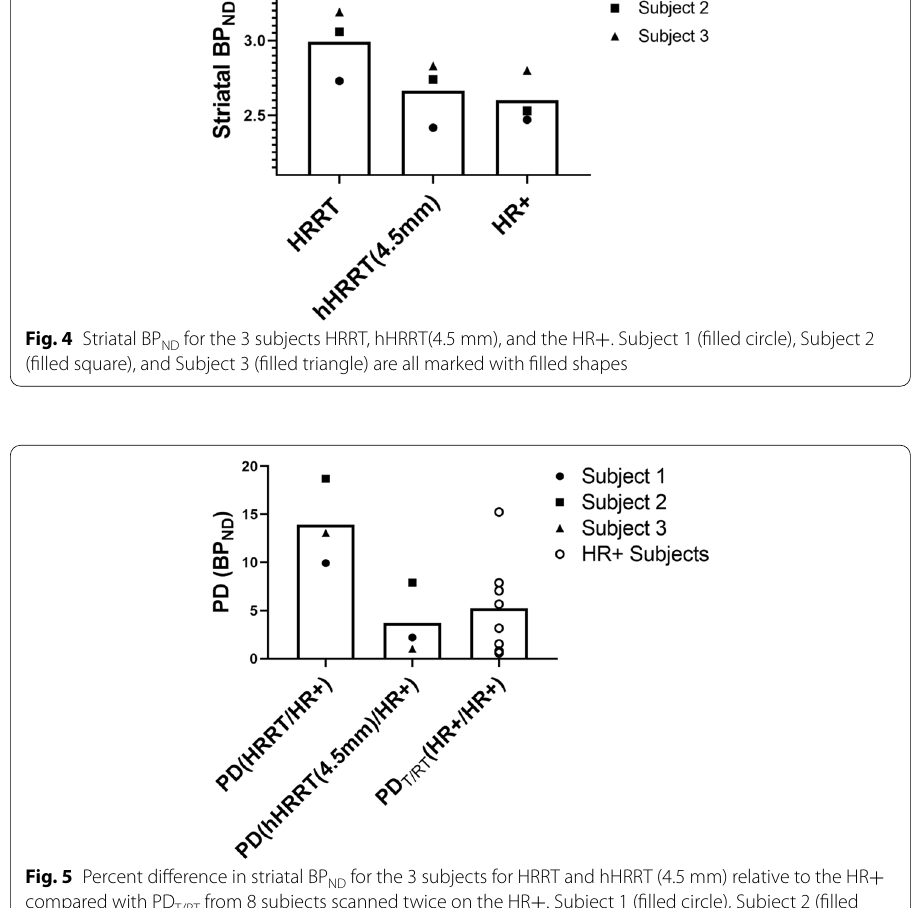
+ . Subject 1 (filled circle), Subject 2 (filled +